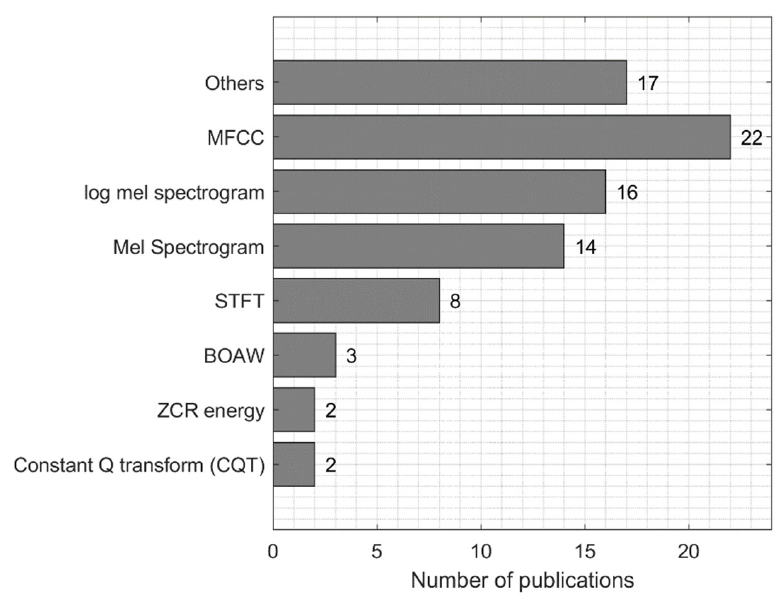
Figure 5. Feature extraction methods used for sound representation.